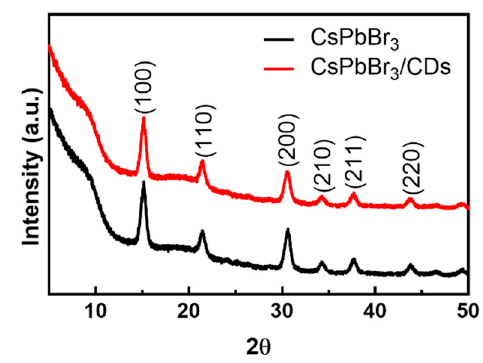
Figure 3. X-ray powder diffraction (XRD) patterns of CsPbBr 3 and CsPbBr 3 /CD film.